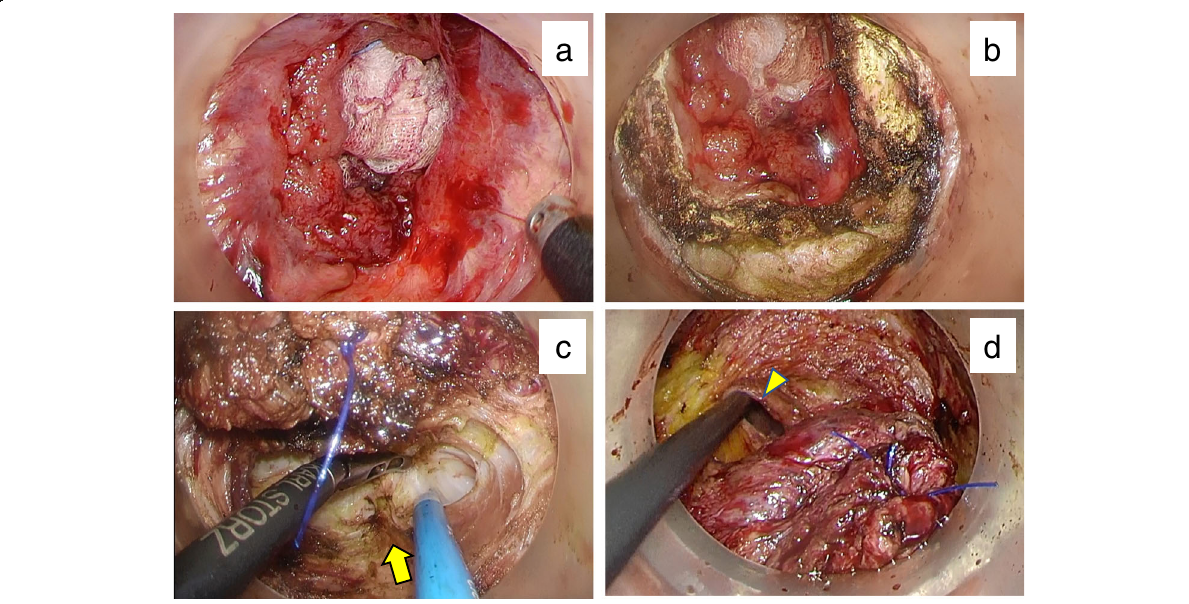
Fig. 4 Intraoperative views of transanal approach. a Distal edge of the tumor. b Circumferential mucosectomy. c Hiatal ligament (arrow). d Abdominal cavity from transanal approach